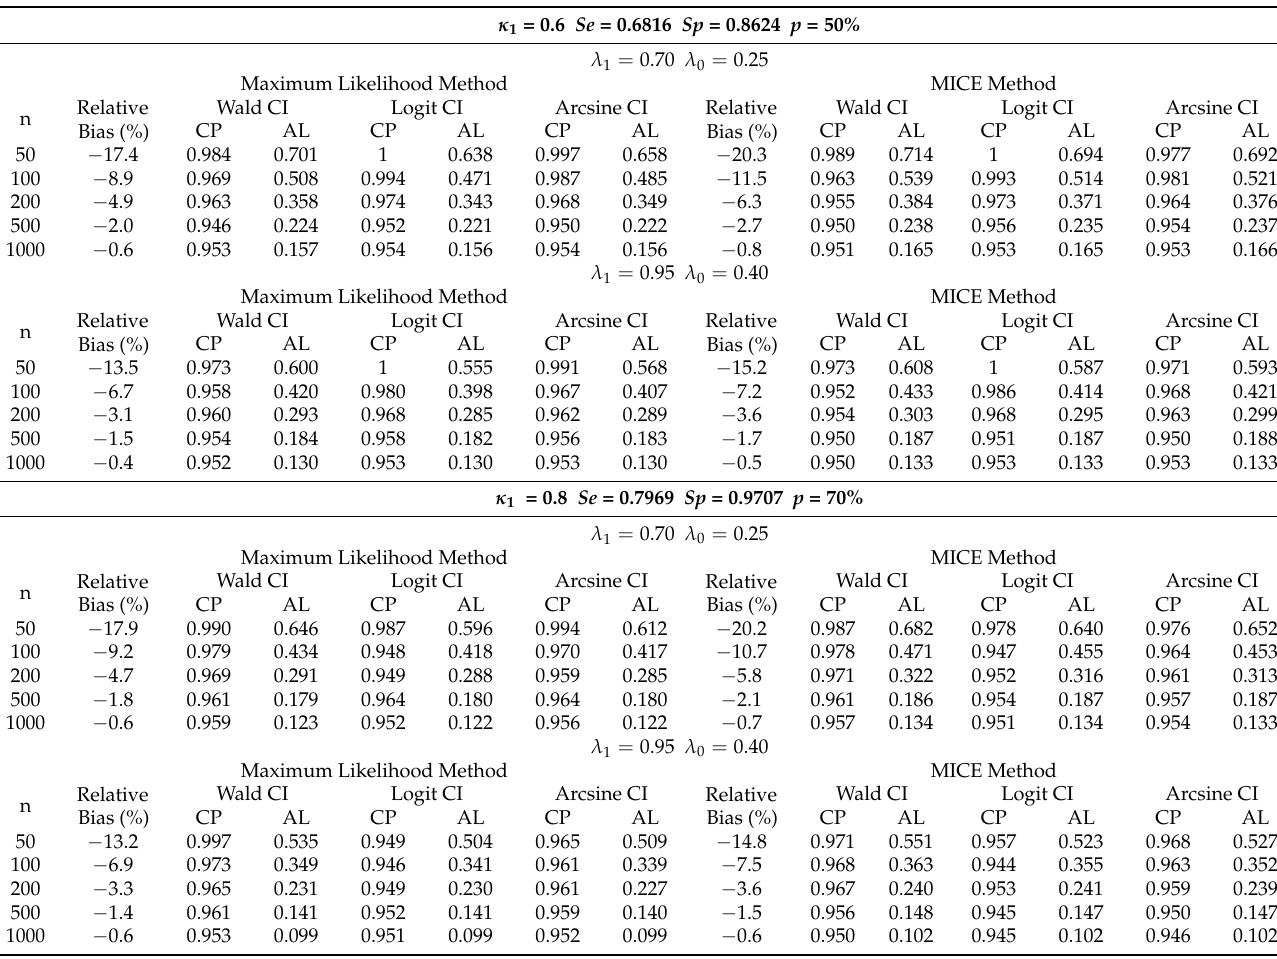
Table 4. Coverage probabilities and average lengths of CIs for κ 1 = { 0.6,0.8 }